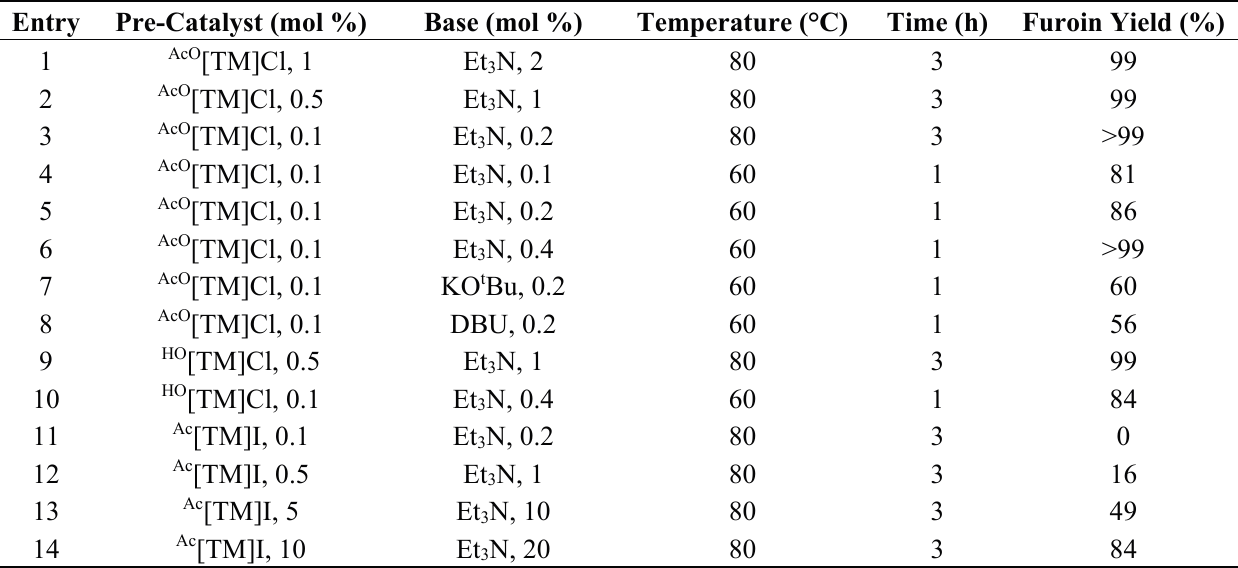
Table 1. Results of self-coupling of FF to furoin catalyzed by thiazolium ILs and